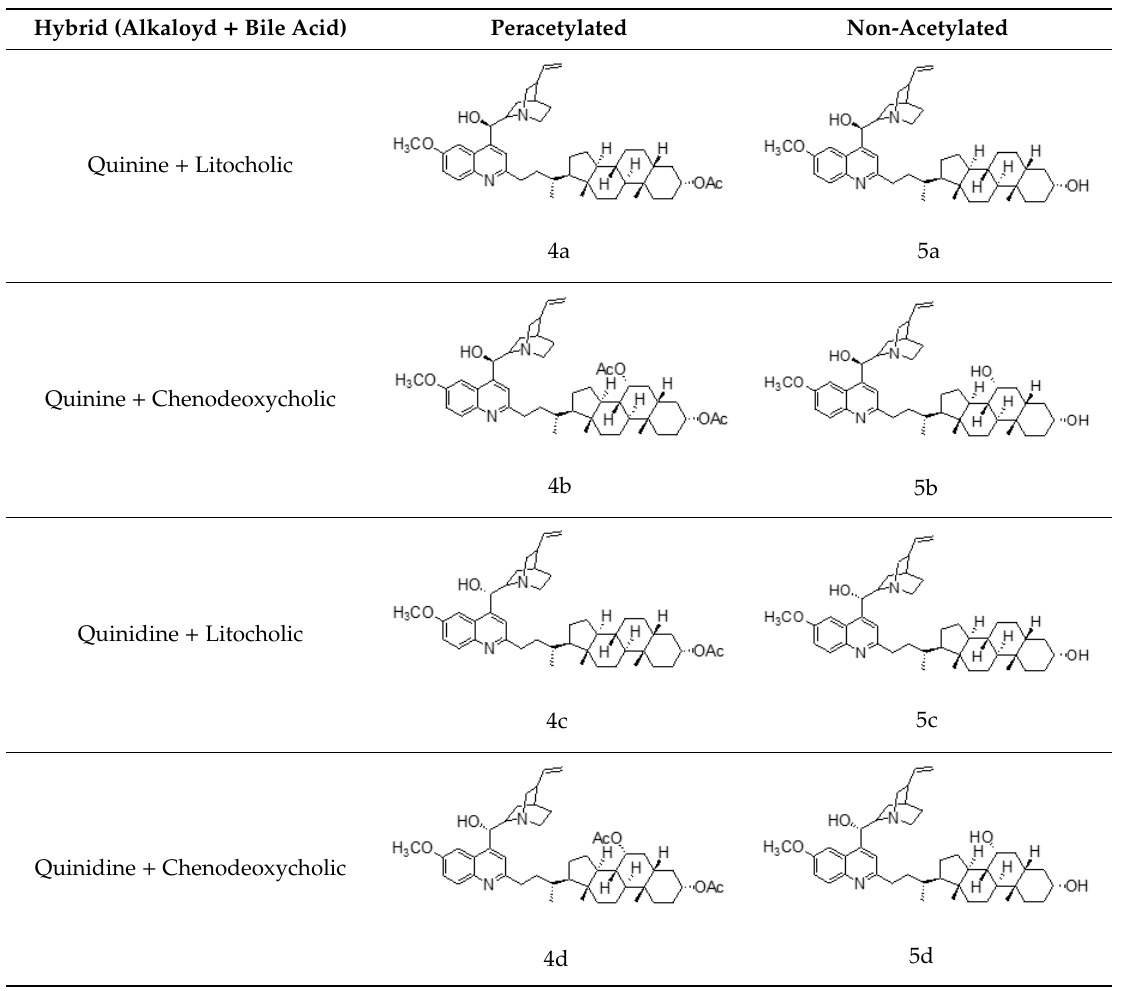
Table 1. Hybrids of Cinchona alkaloids and bile acids were prepared via a Barton – Zard decarboxylation reaction.